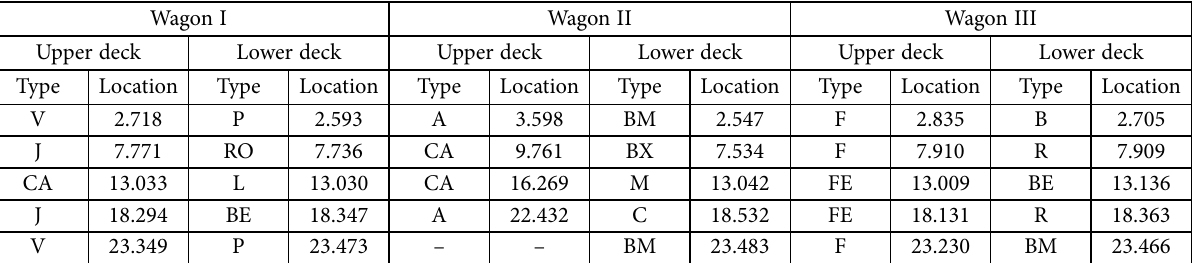
Table 6. Loaded location in the X-axis for each